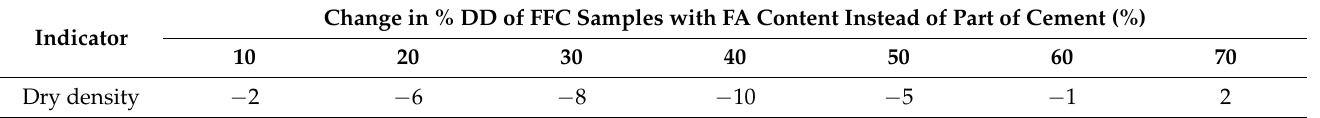
Table 8. Change in DD of FFC samples depending on the percentage of cement replacement with FA.